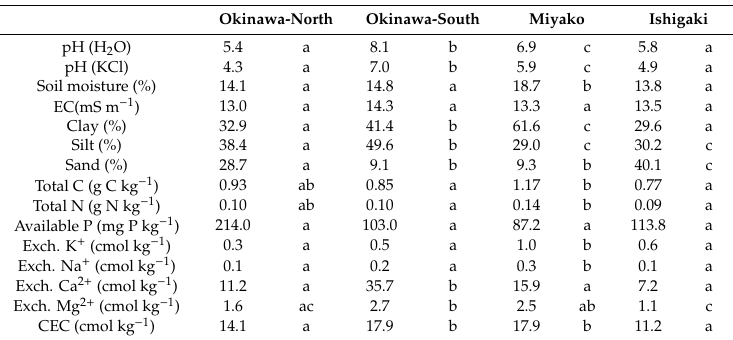
Table 3. Soil physico-chemical properties